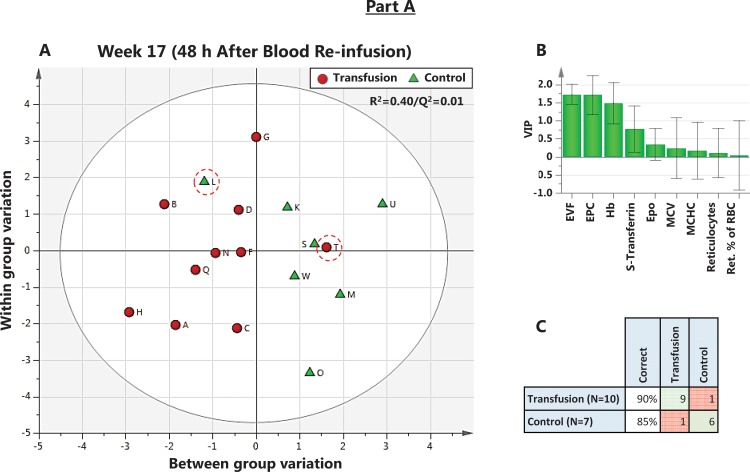
Part A of the Study.An OPLS-DA analysis at 48 h after blood re-infusion. A) Scores Scatter plot showing separation of Control and Transfusion groups 48 h after RBC re-infusion. Observations close to each other are more similar than observations distant from each other. Regression (R 2) = 0.40, and prediction by cross-validation (Q 2) = 0.01. B) VIP rank for included variables. C) Misclassification table showing one incorrectly predicted Transfused (Subject T) to the Control group, and one Control (Subjects L), predicted as Transfused (both circled in red; p = 0.004, Fisher’s exact probability test).